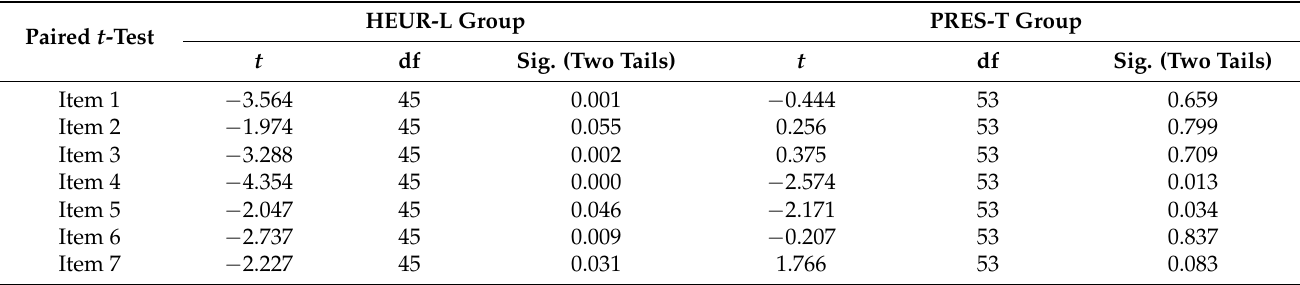
Table 5. Improvement of teamwork skills in each